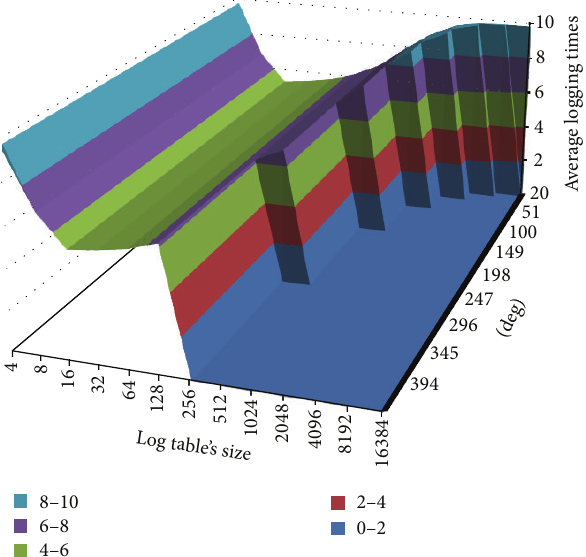
Figure 6: Relation among degrees, table size, and average logging